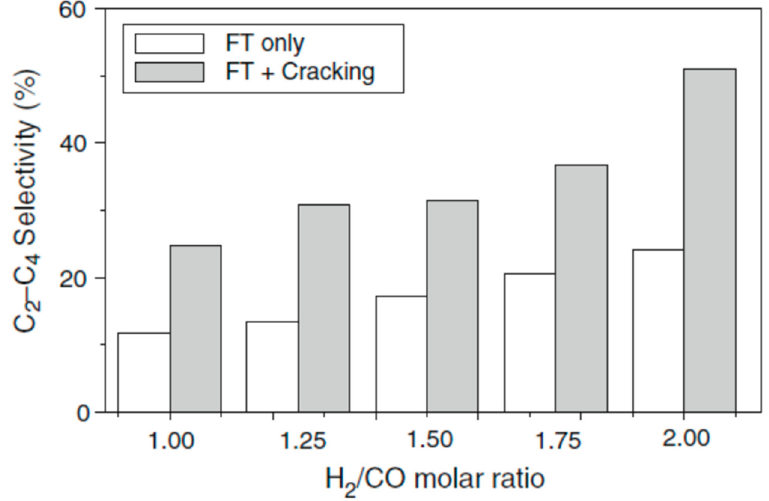
ff ect of dual-bed system Figure 20. Effect of dual-bed system [110]. Figure 20. E